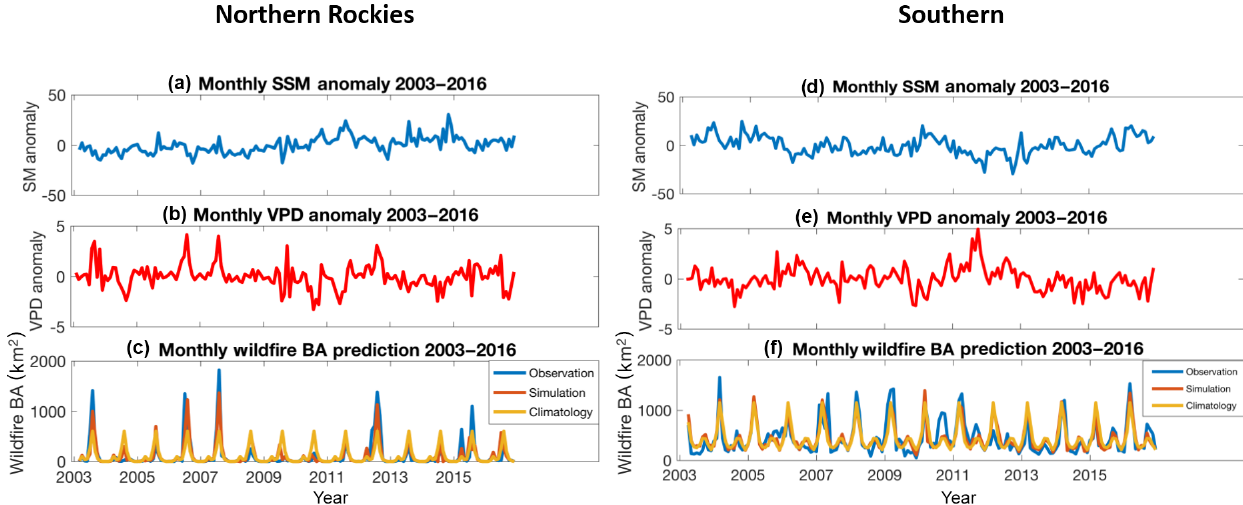
Figure 3. The impact of hydrologic predictors on best- and worst-performing Geographic Area Coordination Center (GACC) models. Monthly time series from 2003 through 2016 show the GACCs with the best (a–c) and worst (d–f) coupled response of burned area (c, f) to vapor pressure deficit anomaly (b, e) and soil moisture anomaly (a, d) , thus demonstrating the respective value added by these variables in the modeled burned area (simulation in orange) compared to the climatology (yellow) and the observations (blue). BA denotes burned area.